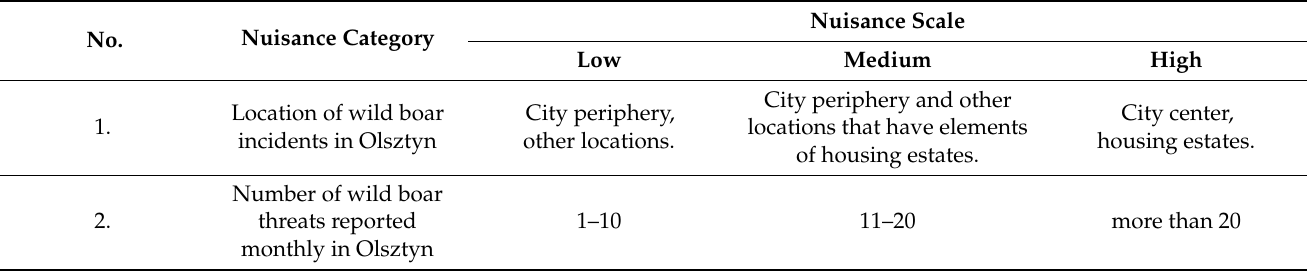
Table 1. Classification of the threats associated with the number and location of wild boar incidents in Olsztyn. No.